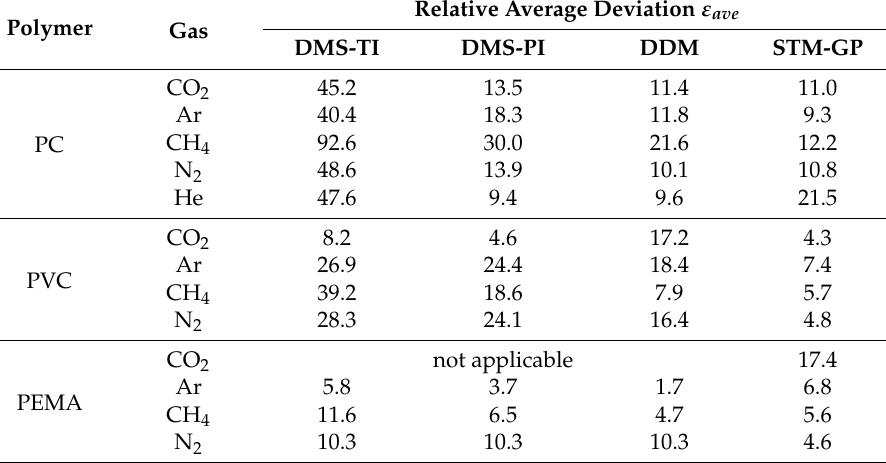
Table 4. Relative average errors ε ave among experimental time lag data and model predictions obtained by the present STM-GP model and by the dual mode based approaches (TI: total immobilization; PI: partial immobilization: DDM: dual